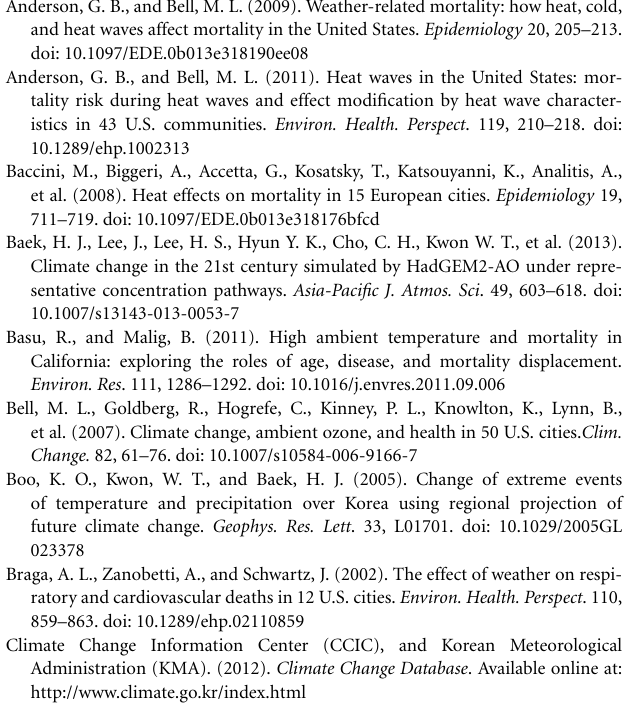
Figure S1 | Scatter plot of observed and simulated daily mean temperature for six cities in Korea during summertime. The daily mean temperature was averaged by day of year for 2001–2008. Figure S2 | Temperature shift during summertime caused by climate change. Dotted vertical red line indicates temperature of current 75th percentile of summer temperature (June to September) and solid red line is for future; White bars are frequency of current and gray bars are future daily mean temperature in summer; T q indicates 75th percentile of temperature during current summer and T (cid:5) q is 75th percentile of temperature during future summer; Gray-colored days between T q and T (cid:5) q are newly added days with temperature over 75th percentile of current summer days ( T q ) in future; Orange-colored days are days with temperature over 75th percentile of future summer days ( T (cid:5) q ). Figure S3 | Sum of heat-related mortality attributable to climate change in six cities, South Korea. Vertical bars indicate 95% confidence intervals reflecting statistical uncertainty in risk estimation.